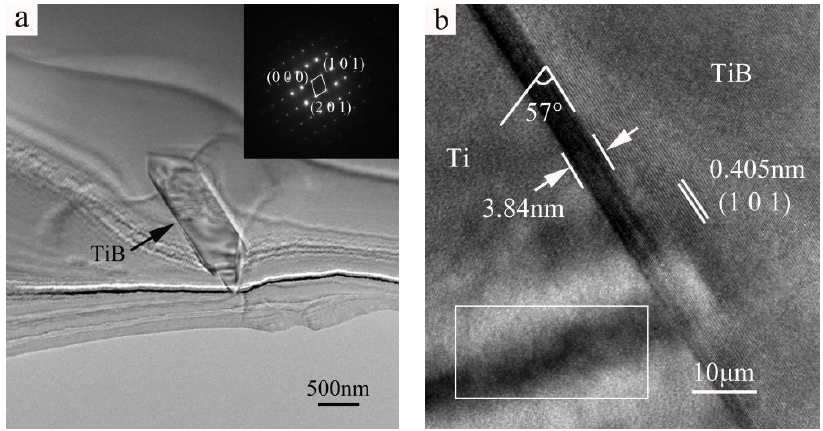
Figure 8. HRTEM morphology of TiB: ( a ) selected area electron diffraction pattern; ( b ) TiB grain boundaries.